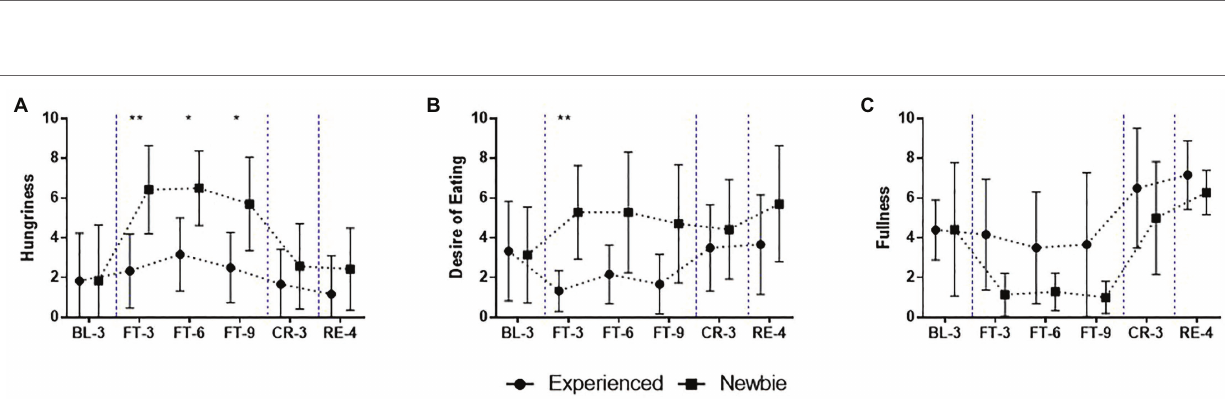
FIGURE 2 | Mean and SD of physiological scores over the 22-day experiment for the Experienced and Newbie groups. (A-C) The scores of the three basic physiological variables. Symbols represent mean scores for two groups, and error bars represent the SD of the mean. * p < 0.05 indicates significant differences between the two groups at that test point. Blue dashed lines indicate the different sessions.